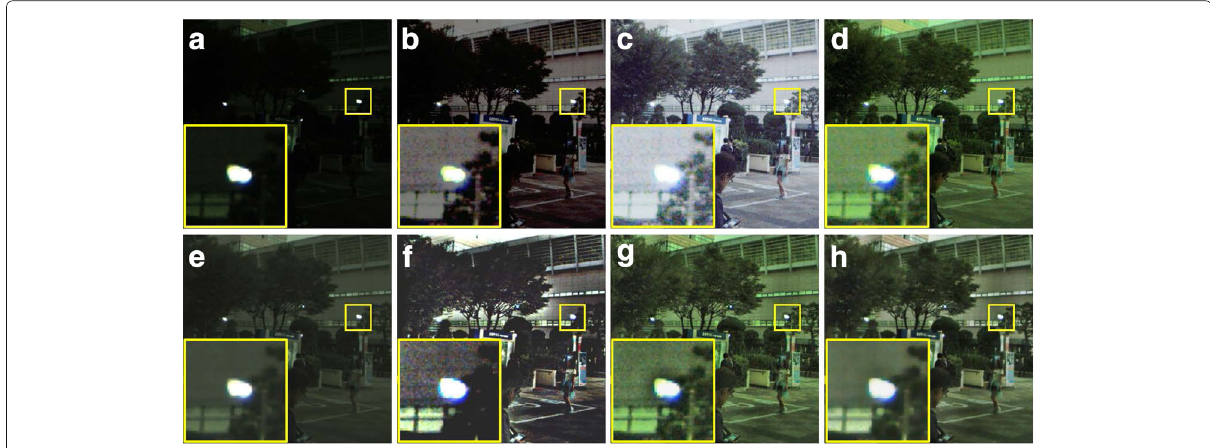
Fig. 10 Result of the proposed and conventional methods: a input image, b Chen’s method [2], c Kim’s method [3], d Jiang’s method [8], e Ravi’s method [23], f Jobson’s method [14], g Fu’s method [16], and h the proposed method ( λ 1 = 300, λ 2 = 0.1, λ 3 = 0.9, and ω =